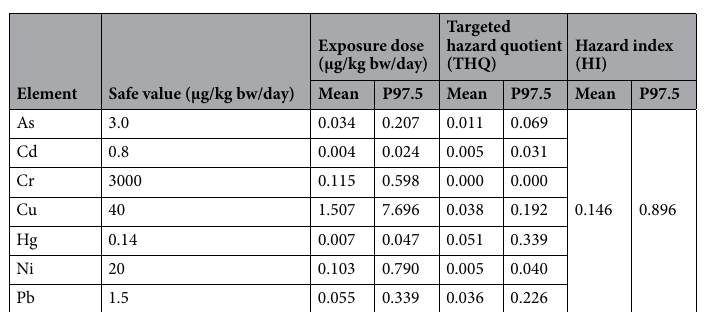
Targeted hazard quotient (THQ)